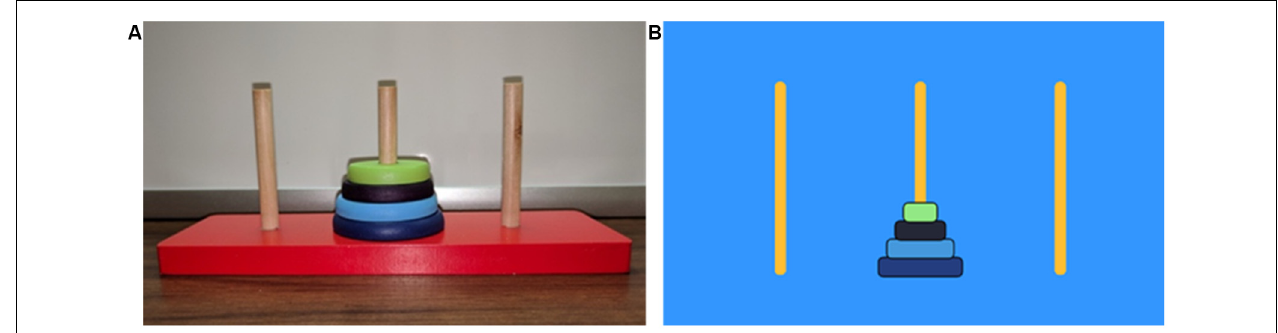
FIGURE 1 | Different Tower of Hanoi (ToH) conditions. (A) Three-dimensional (3D) condition performed by using one hand to move disks and the other hand to hold the frame. (B) Two-dimensional (2D) condition performed on a PC computer using one hand to manipulate a mouse.